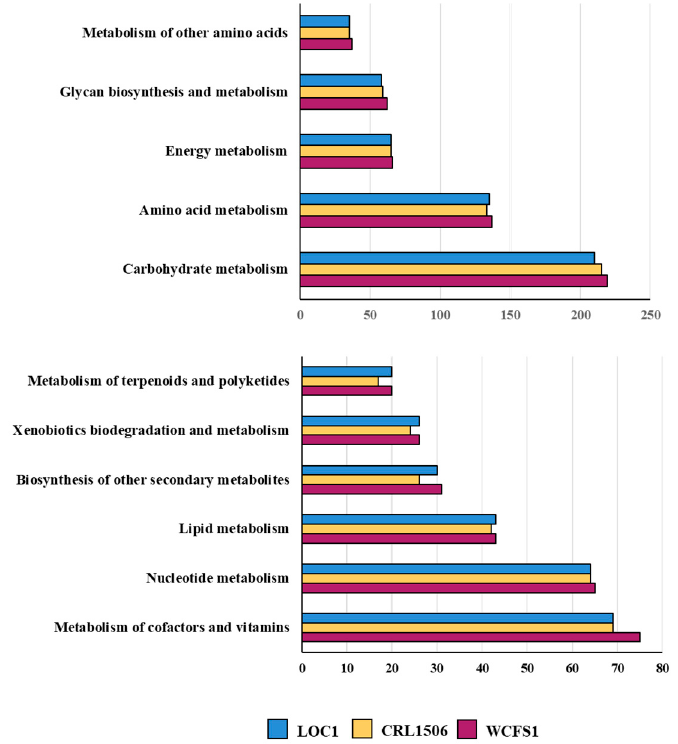
Figure 7. Study of the number of genes in the different functional categories associated with metabolic pathways of the genome of Lactiplantibacillus plantarum LOC1. The genome of the LOC1 strain was studied and compared with the probiotic strains WCFS1 and CRL1506 as reference. Functional characterization of genes was performed with the BlastKOALA tool according to the KEGG database.